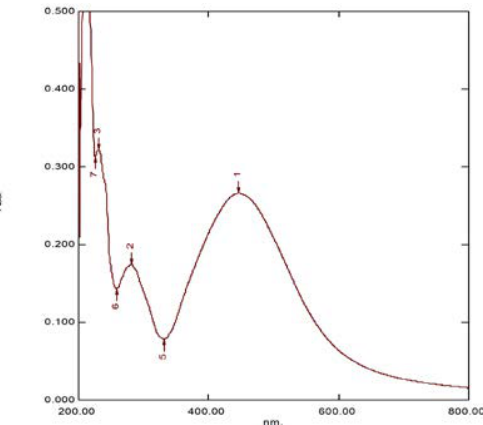
Fig. 2. UV -Visible spectra of Psidium guajava silver